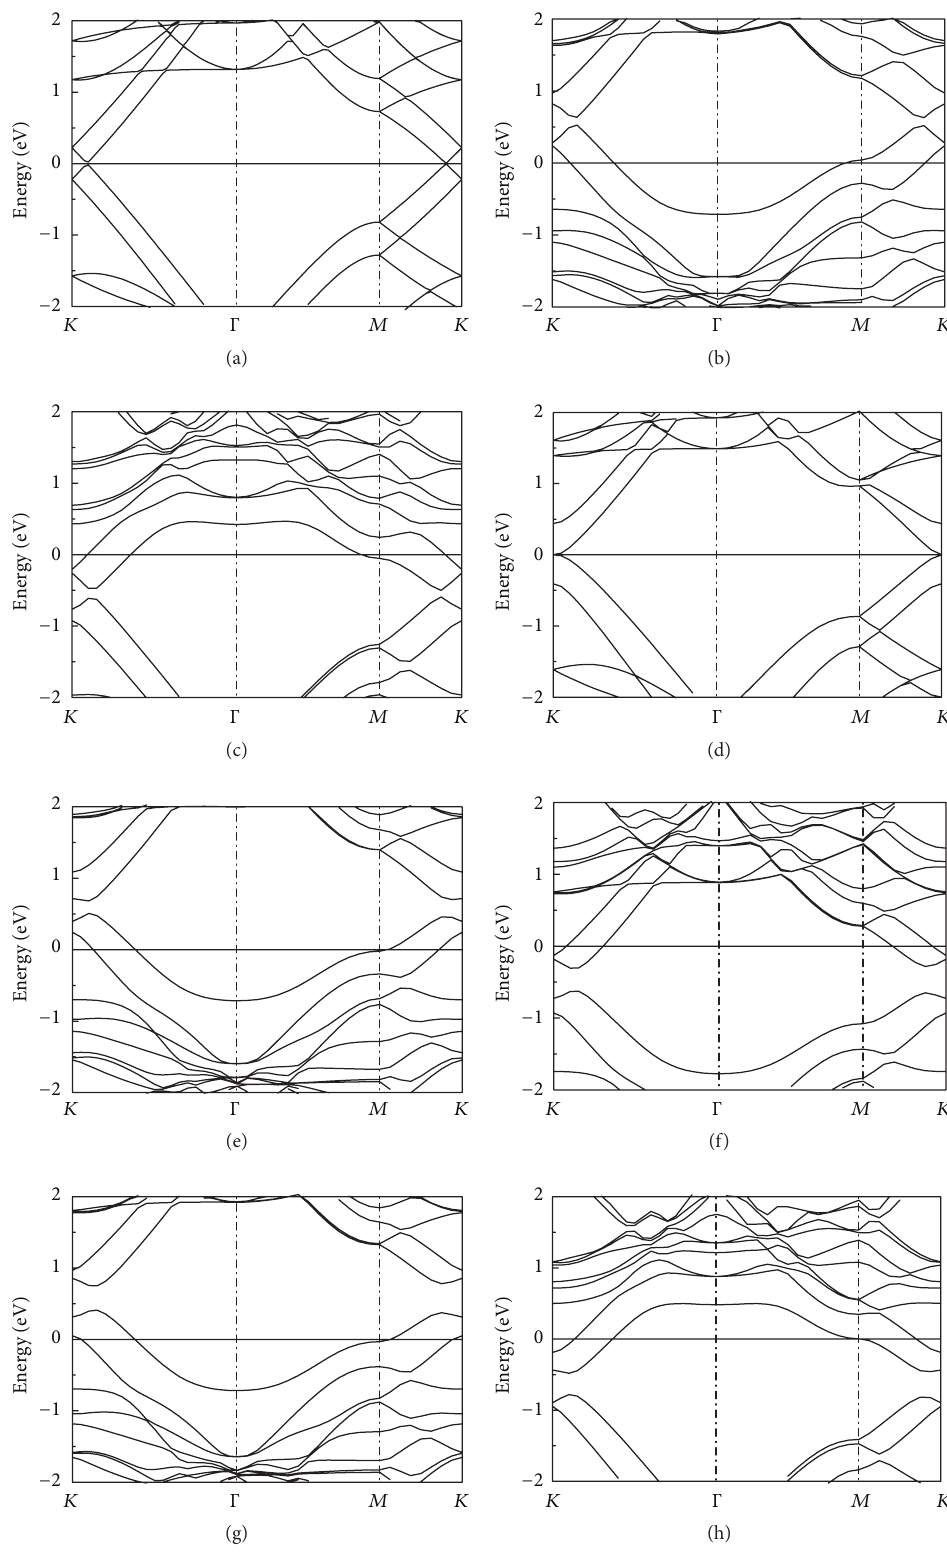
Figure 6: Electronic band structures of (a) undoped pristine AA -stacked, (b) B-doped AA -stacked, (c) N-doped AA -stacked, (d) undoped pristine AB -stacked, (e) B-doped AB1 -stacked, (f) N-doped AB1 -stacked, (g) B-doped AB2 -stacked, and (h) N-doped AB2 -stacked bilayer graphenes. The Fermi energy is set to be zero. Reproduced with permission from [57], copyright, 2015